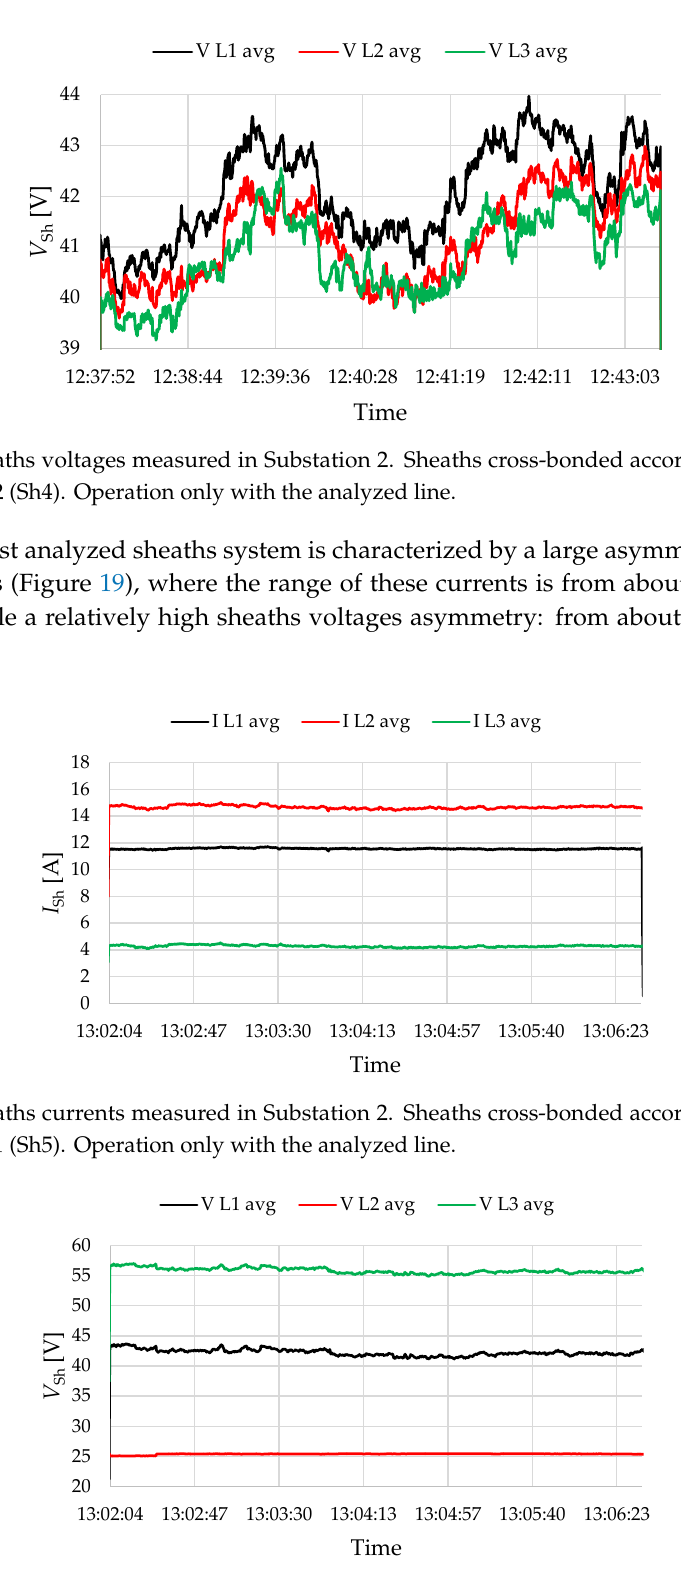
Figure 20. Sheaths voltages measured in Substation 2. Sheaths cross-bonded according to: L1 → L3, L2 → L2, L3 → L1 (Sh5). Operation only with the analyzed line.